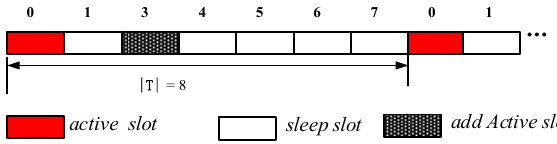
Figure 6. The time slot with an added active time slot.